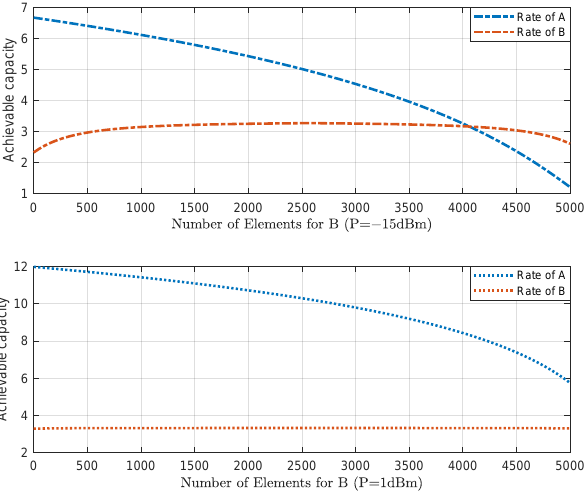
Figure 5. Ergodic rate for users A and B versus the reflecting elements number.